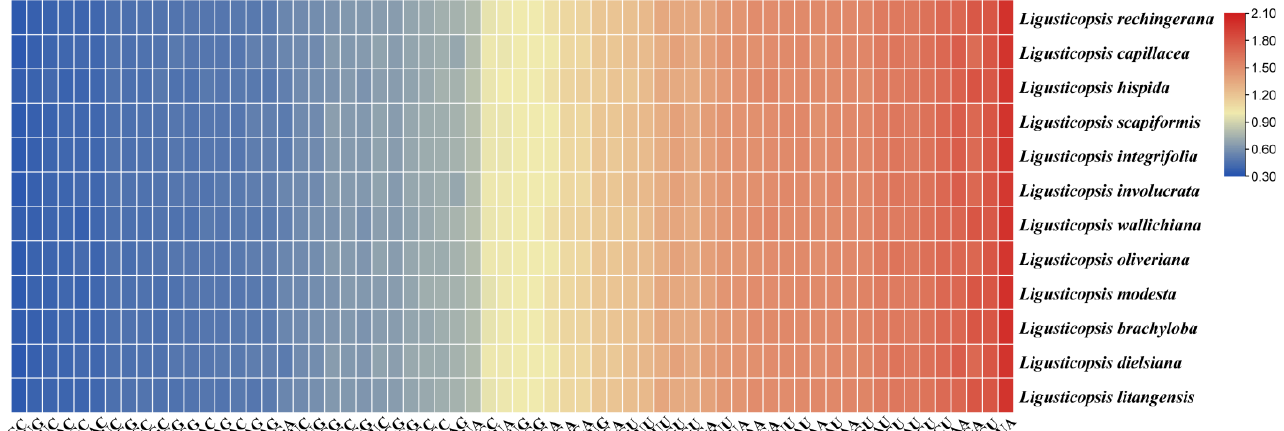
Figure 7. The RSCU values of all concatenated protein-coding genes for twelve plastomes. Color key: the red values mean higher RSCU values and the blue values mean lower RSCU values.